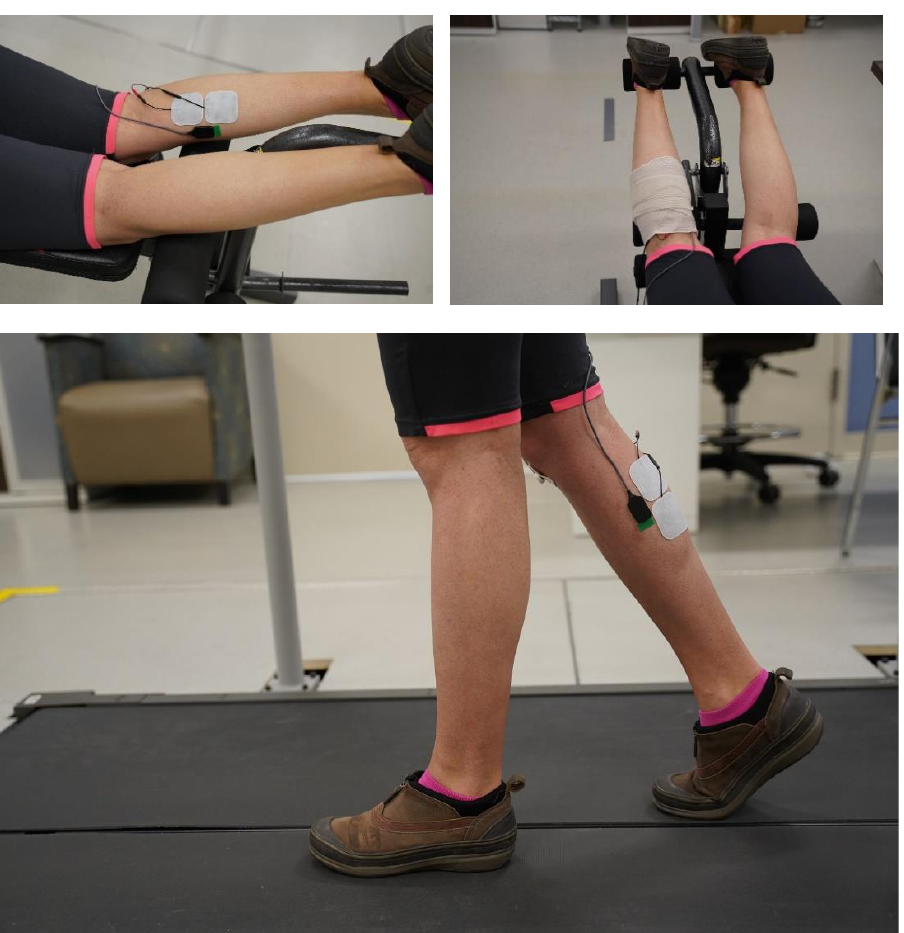
Figure 4. ( Top Left ) mTrigger and DELSYS electrode placement. Electrodes were placed on the medial gastrocnemius with DELSYS electrode always medial to mTrigger electrodes. ( Top Right ) A flex wrap was used to minimize electrode movement and wired movement. Wraps were removed to illustrate electrodes in different positions and different data collection settings. ( Bottom ) Participant in a push-off position walking on a treadmill.